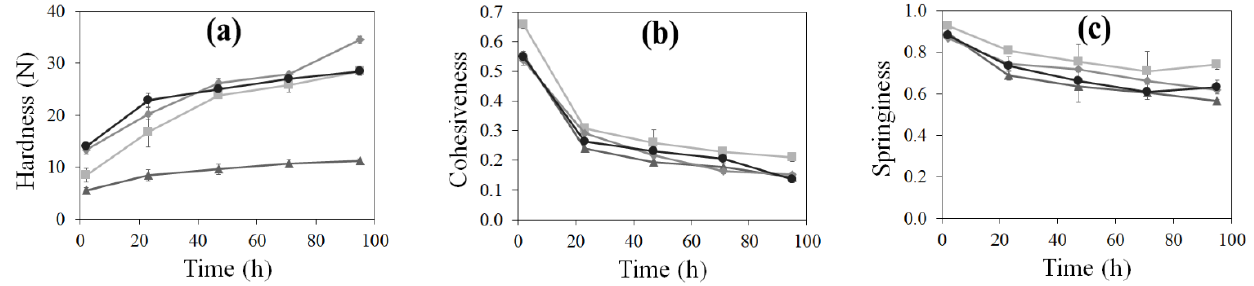
Figure 2. Evolution of crumb texture (( a ) hardness (N); ( b ) cohesiveness; ( c ) springiness) during storage. RF ( ■ ), RF+CF ( ♦ ), RF+RCF ( ▲ ) and RF+DCF (●); RF, rice flour; CF, raw chickpea flour; RCF, roasted chickpea flour; DCF, dehulled chickpea flour.